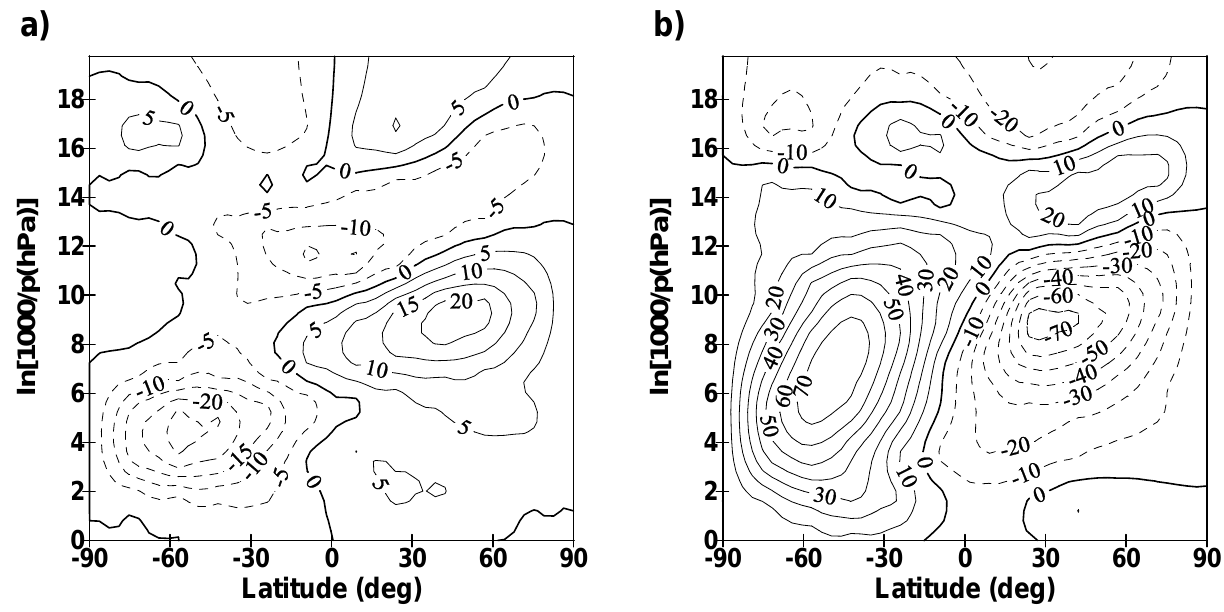
Fig. 3. Latitude-height distributions of velocity of background zonal wind inm/s (positive eastward) for 16 March ( a ) and 1 July ( b ) from the HWM-93 model (Hedin et al., 1996), used in simulating the planetary